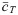
Solutions for cytosolic calcium concentration, ci, as a function of total calcium concentration, c¯T.Discontinuous lines represent unstable solutions while continuous lines stable ones.